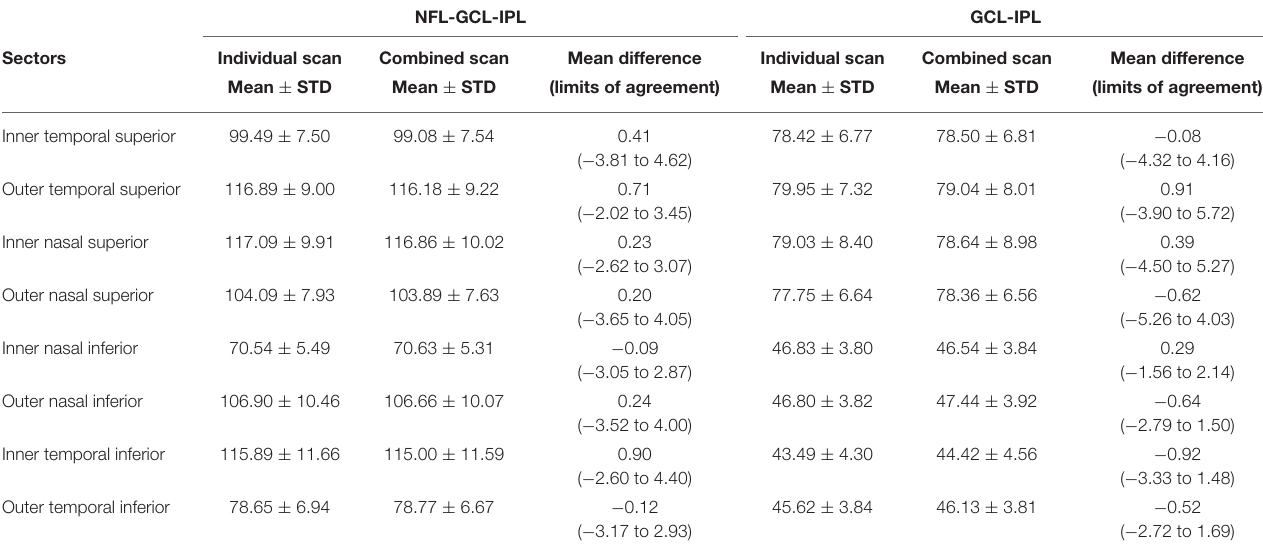
TABLE 3 | Ganglion cell complex thickness in macula for 8 different sectors with two scan modes, and the agreement